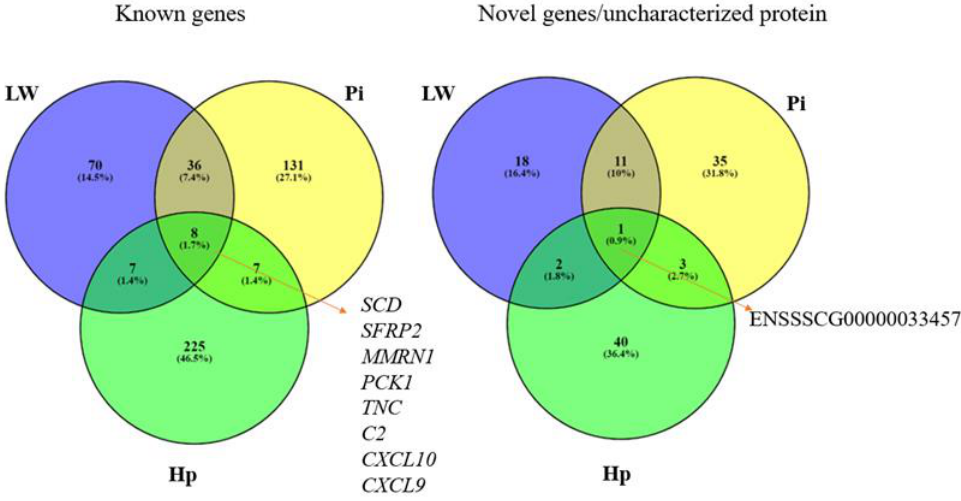
Figure 1. Comparison of differentially-expressed genes (DEGs) between subcutaneous fat tissue varying in thickness in each of three breeds (LW, Large White; Pi, Pietrain; and Hp, Hampshire).